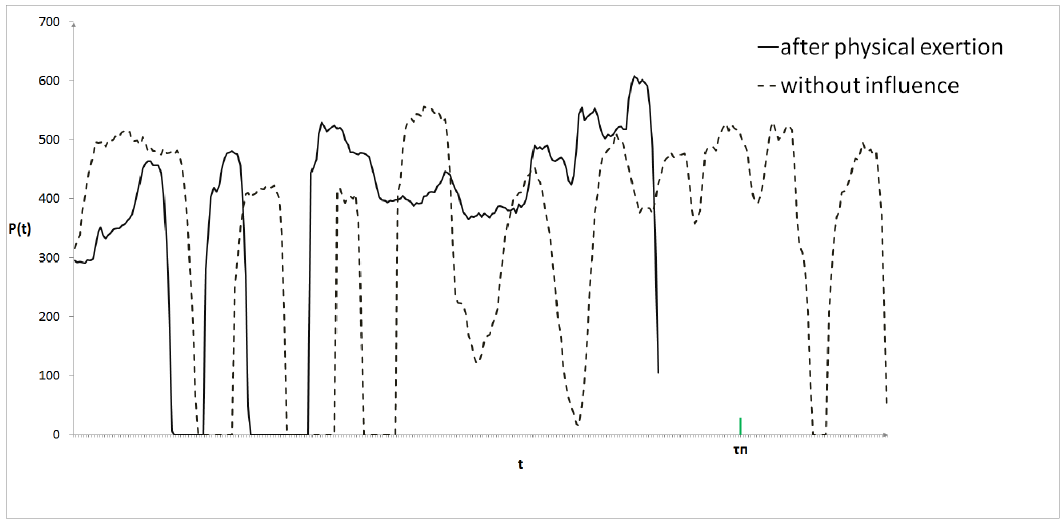
Figure 3. The pen pressure function at the output of a graphic tablet while employee reproduces a signature being in different psychophysiological states.